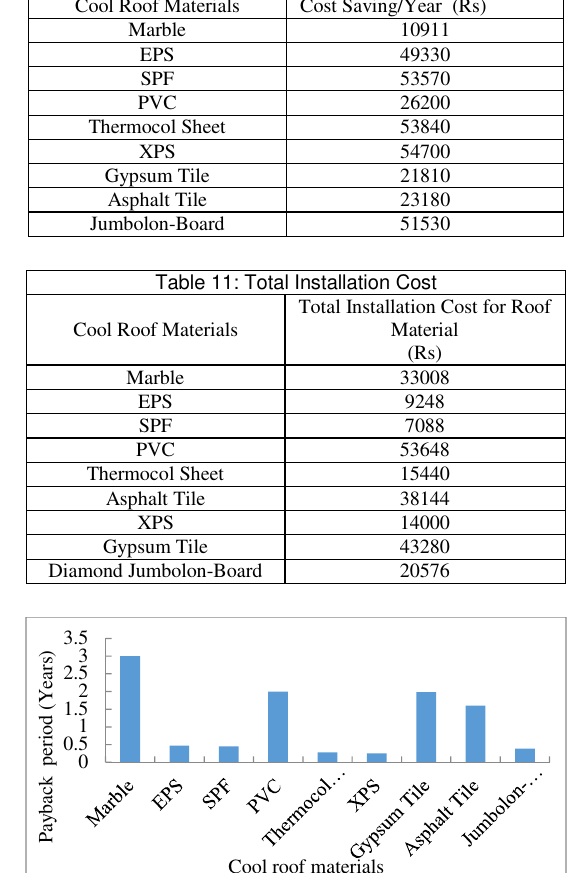
Table 10: Cost Saving of Cool Roof Materials Cool Roof Materials